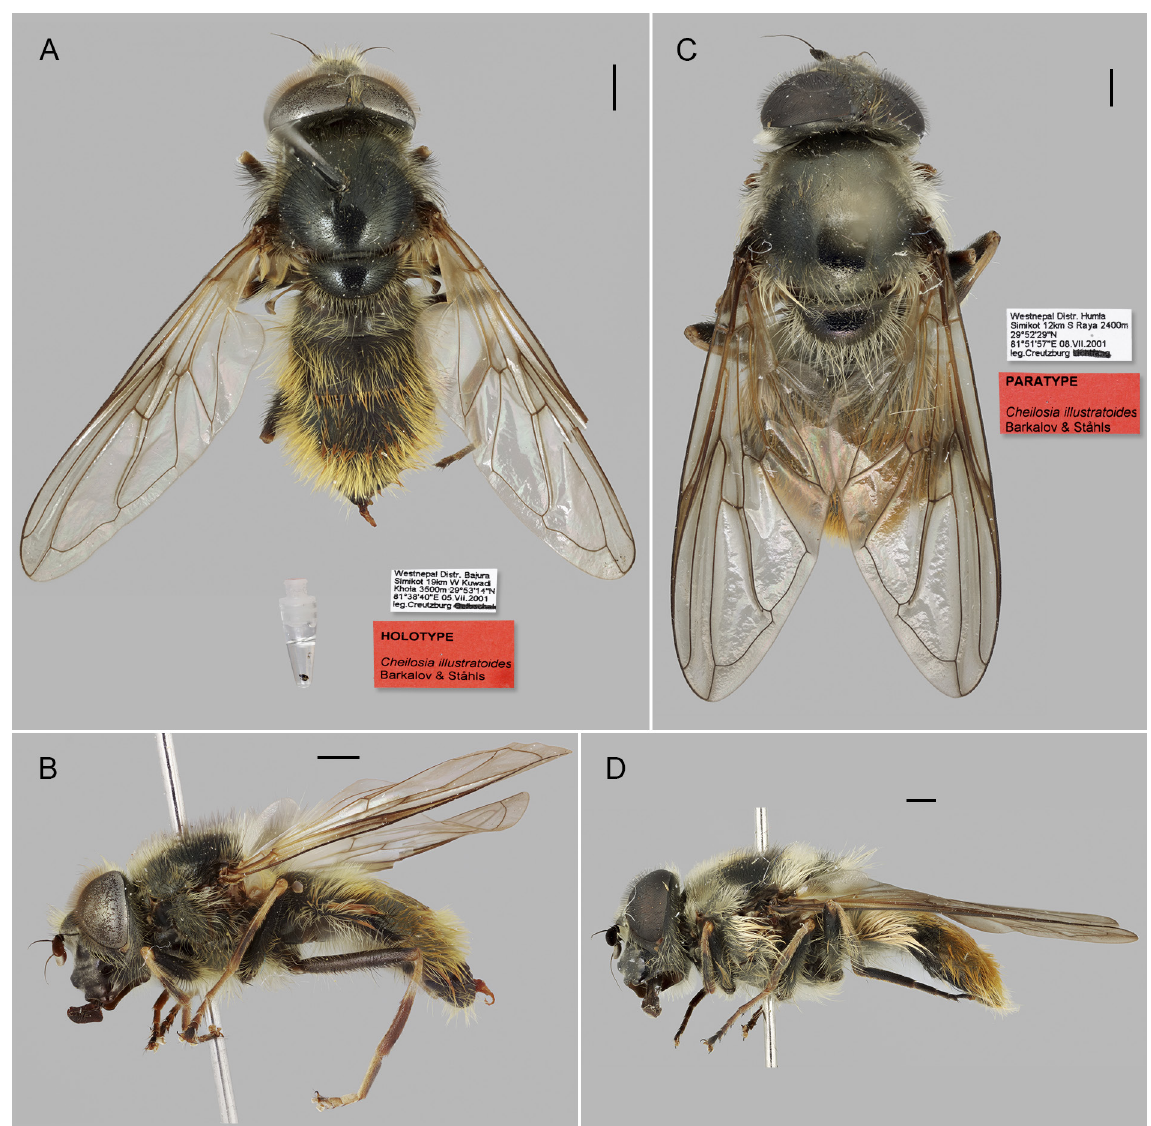
Fig. 30. Cheilosia ( Floccocheila ) illustratoides sp. nov. A–B . Holotype, ♂ (NME); dorsal and lateral views. C–D . Paratype, ♀ (NME); dorsal and lateral views. Photo: Pekka Malinen, FMNH Luomus. Scale bars = 1